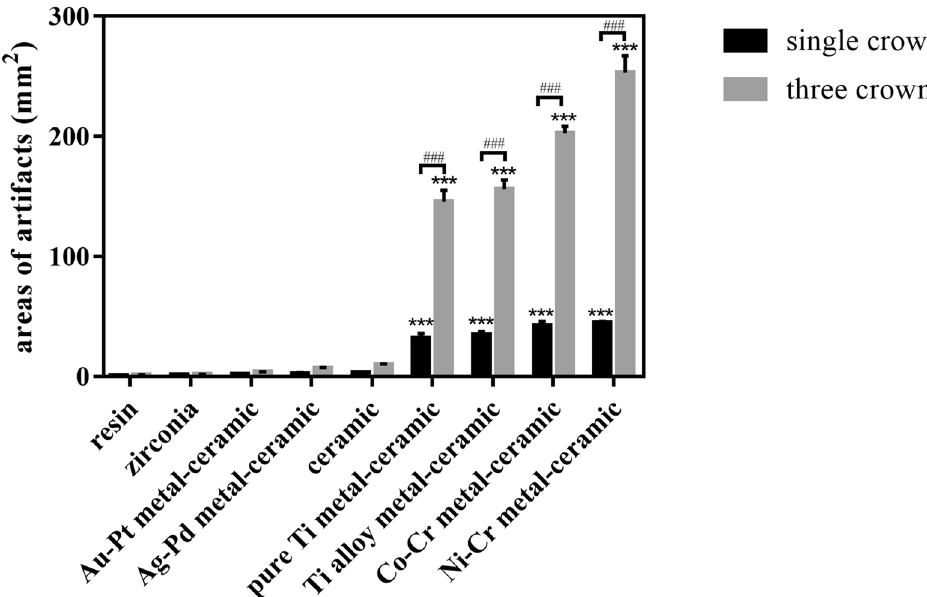
Figure 4. Quantitative analysis of artifacts produced by the single or three crowns of nine different materials. ( # P < 0.05, ## P ≤ 0.01, and ### P ≤ 0.001 between each group. *, **, and *** indicate significant differences in comparison with the resin group. * P < 0.05, ** P ≤ 0.01, and *** P ≤